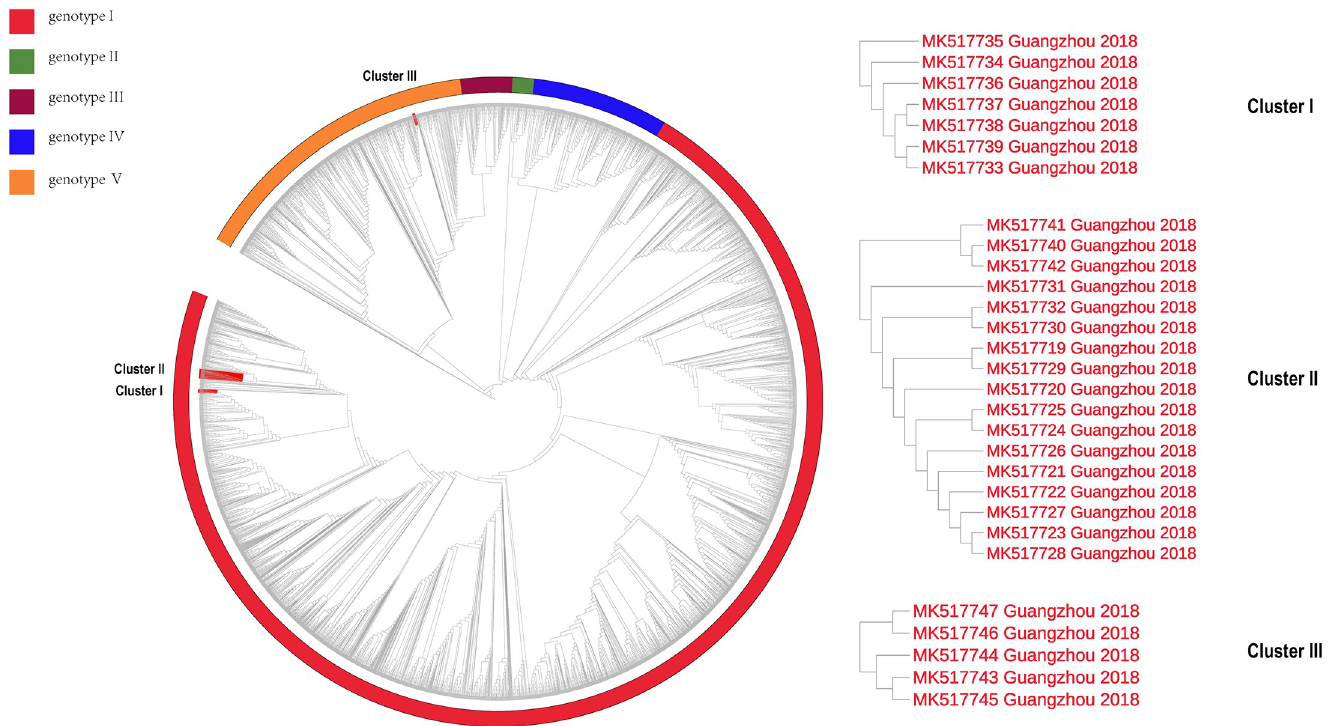
Fig 2. Maximum likelihood tree for global dataset reconstruction of DENV-1. The maximum likelihood tree result of DENV-1 is shown in the figure. The sample sequence clusters under different branches, and the red blocks labeled in the branches in the figure are clusters of sample sequence clusters. Different color blocks outside the branches represent different genotypes.